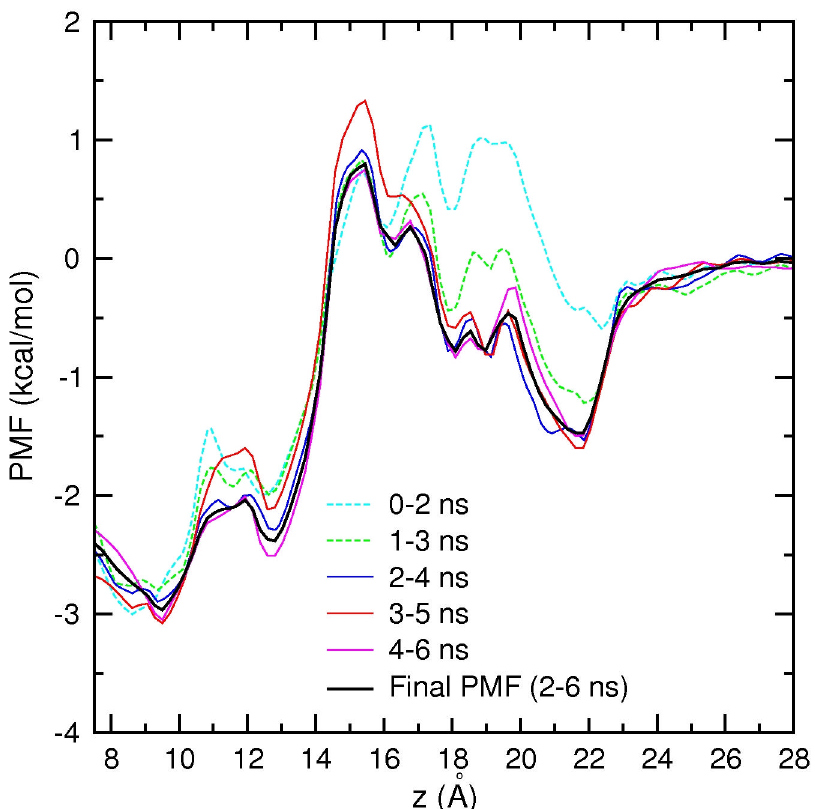
Fig 7. PMF of a Na + ion in the Na V 1.4 channel with no resident Na + ions. Block data analysis using 2 ns blocks indicates that the PMF converges after 2 ns of equilibration. Therefore the first 2 ns is excluded, and the final PMF is obtained from 2 – 6 ns of the